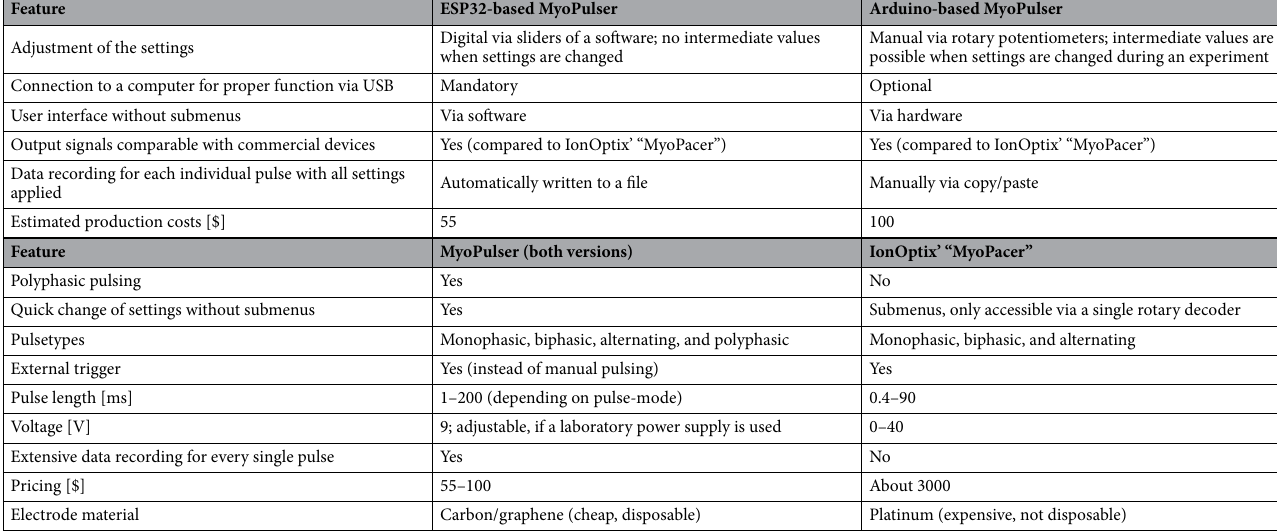
Table 1. Features of the ESP32- and Arduino-based MyoPulser